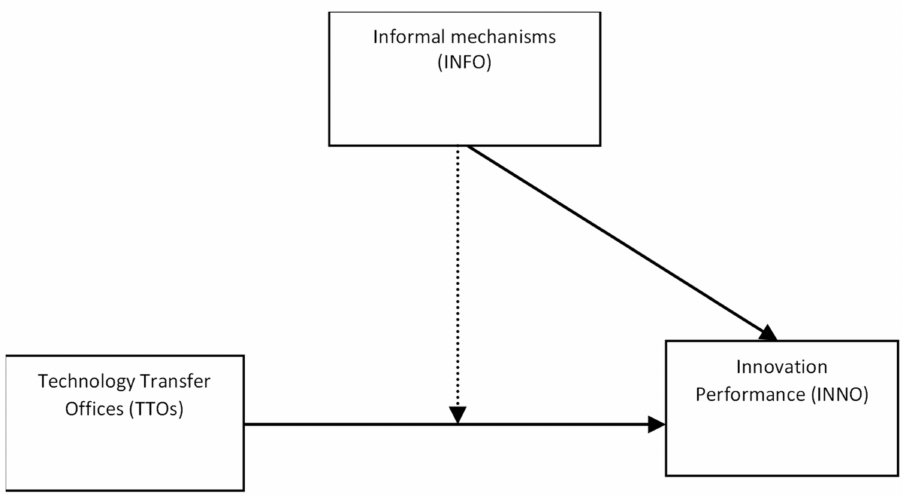
Figure 2. Conceptual model. Source: